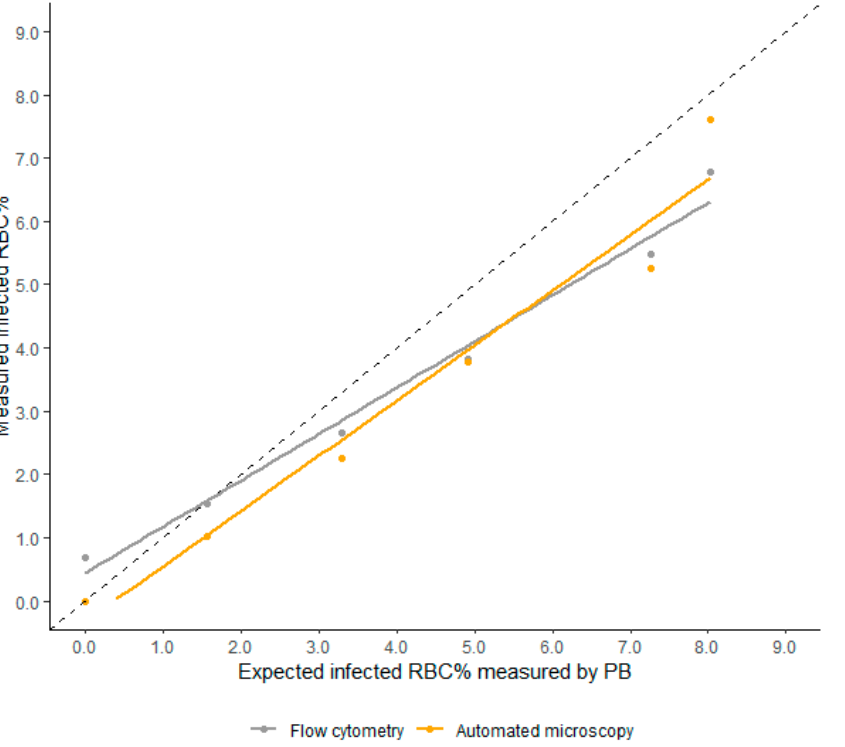
Figure 4. Linearity of percentage infected RBCs evaluated using P. falciparum culture. Both the automated microscopic malaria parasite detection system (orange colored) and flow cytometry (gray colored) showed high degree of linearity, with a coefficient of determination (R 2 ) of 0.958 ( p = 0.005) and 0.984 ( p = 0.001), respectively. The dash-lines indicate a 1:1 line.